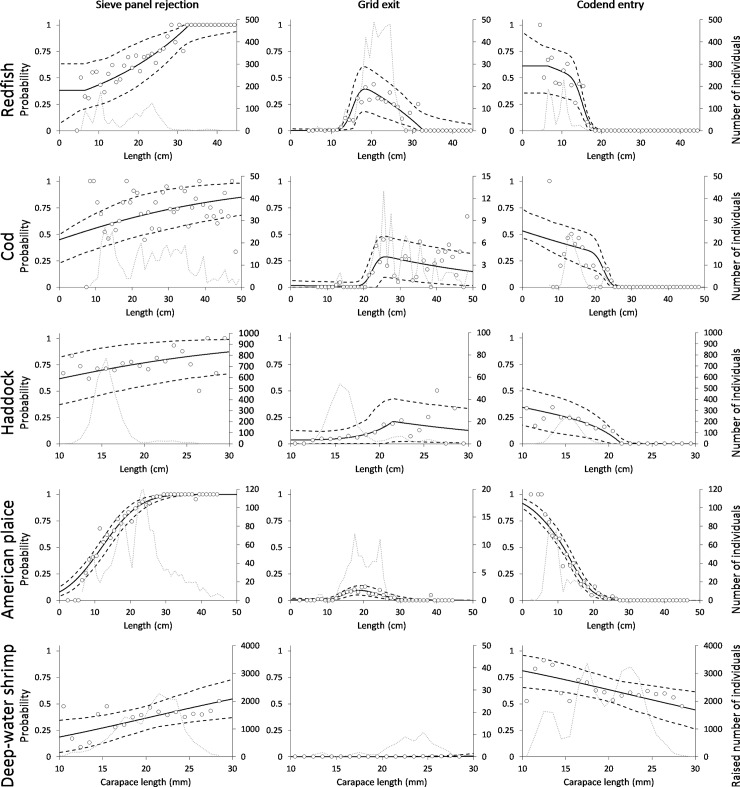
Modelling of the length-dependent observed experimental release and retention rates.Left column: release share to sieve panel cover (sieve panel rejection probability). Centre column: release share to Nordmøre grid cover (grid exit probability). Right column: catch share to blinded codend (codend entry probability). Data for redfish are shown in the first row, followed by cod, haddock, American plaice and deep-water shrimp in the bottom row. Circle marks represent the observed experimental rate and the solid black curve represents the modelled rate. Black dashed curves represent 95% confidence bands for the modelled rate and the grey dotted curve represents the observed experimental catch in the specific compartment (sieve panel cover, grid cover and blinded codend).